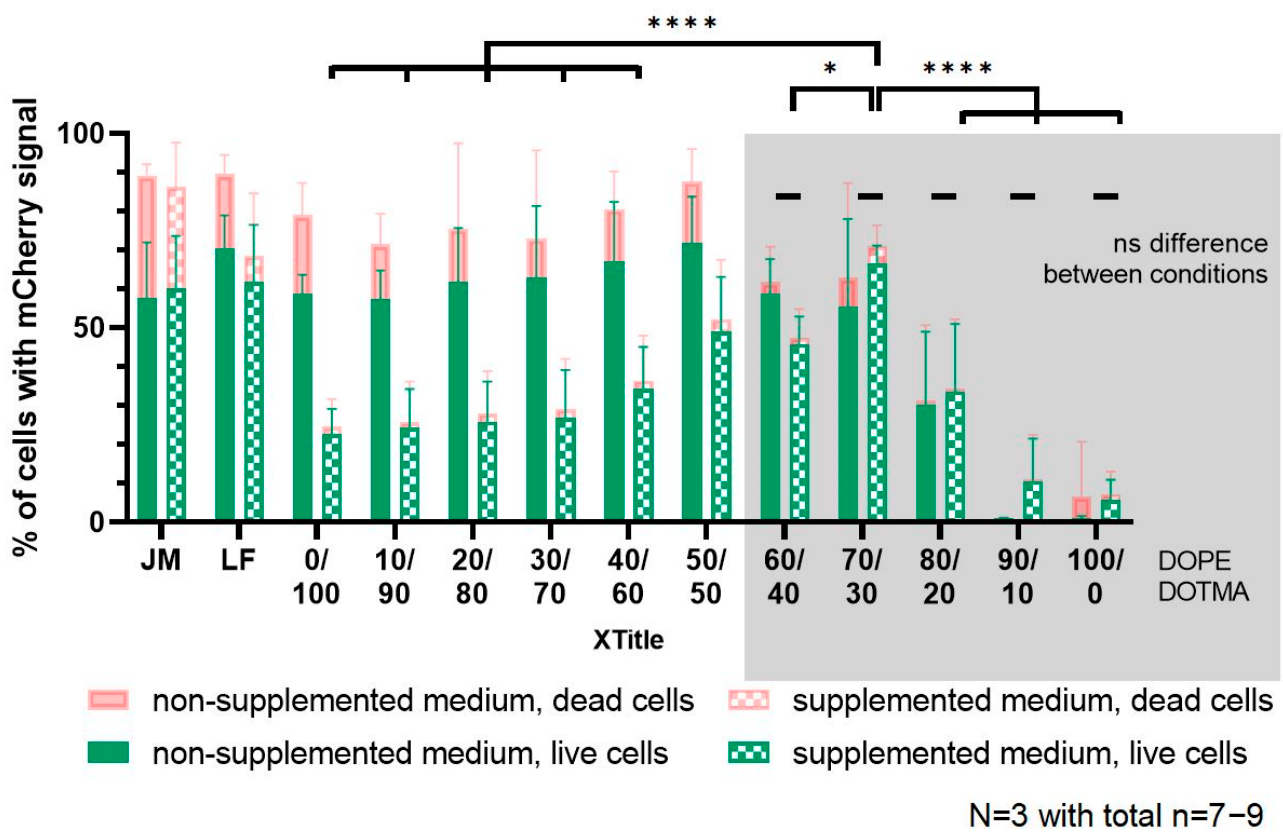
Figure 8. Transfection efficacy in dependence of the medium supplementation. DC2.4 cells were transfected with FITC-labeled LPNs loaded with mCherry mRNA for 24 h in plain RPMI or RPMI supplemented with 10% FCS, HEPES-buffer, non-essential amino acids and β -mercaptoethanol. Each bar shows an overlay of live transfected cells (green bars) and transfected cells in the entire, acquired cell population (pink bars). DAPI staining was used to identify cell membrane damage and to distinguish between live and dead cells. Commercial transfection reagents JetMESSENGER (JM) and Lipofectin (LF) as control samples. Differences between medium conditions get insignificant at samples with DOPE content ≥ 60% (grey box). Ratio 70/30 is the optimum sample for good transfection efficacy independent of the presence of serum. (* p < 0.05; **** p <